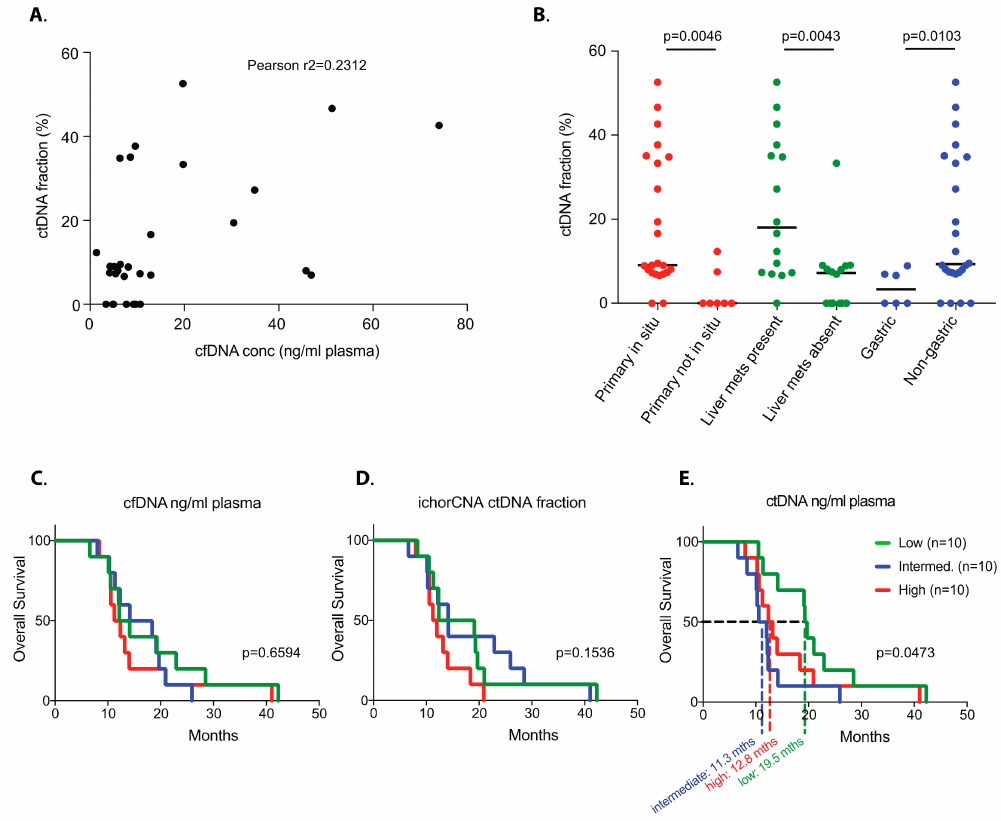
Figure 1. ( A ) No correlation between circulating free (cf)DNA concentration and the tumour-derived cfDNA fraction in 30 plasma samples from patients with treatment naïve metastatic gastro-oesophageal cancers. ( B ) Correlation between selected clinical features and circulating tumour (ct)DNA fraction